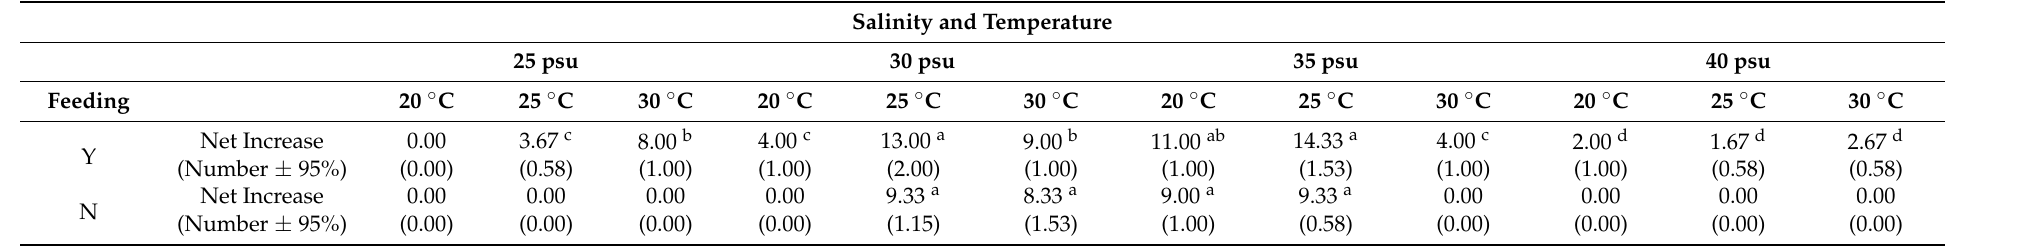
Table 3. The effect of feeding on Briareum violacea growth under temperature and salinity stress.